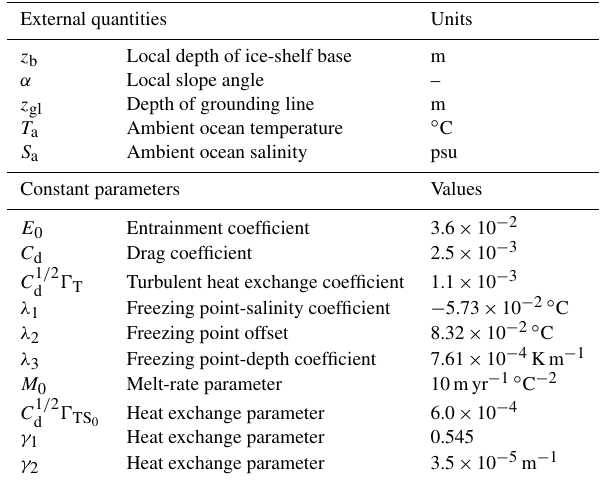
Table 1. Physical quantities and constant parameters serving as in- put for the basal melt